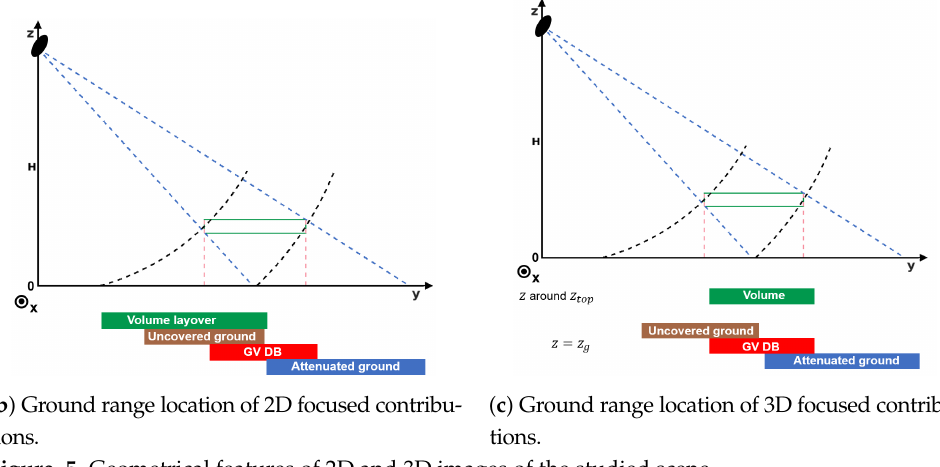
Figure 5. Geometrical features of 2D and 3D images of the studied